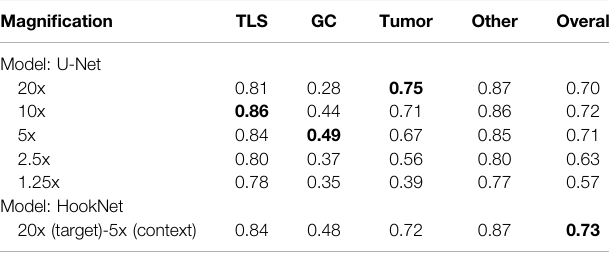
TABLE 6 | Performance of the U-Net (above) and HookNet (below) on the lung dataset. ThearchitecturesarecomparedontheF1score,foreach tissue type (description of the tissue type in the Supplementary Material ). The overall macro-F1 score is reported. The values marked in bold highlight the method that reaches the highest performance, respect to the